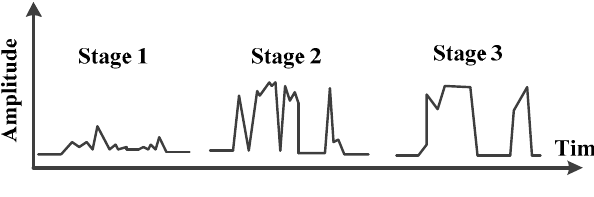
Figure 3. Evolution of intermittent failure dynamics [11].